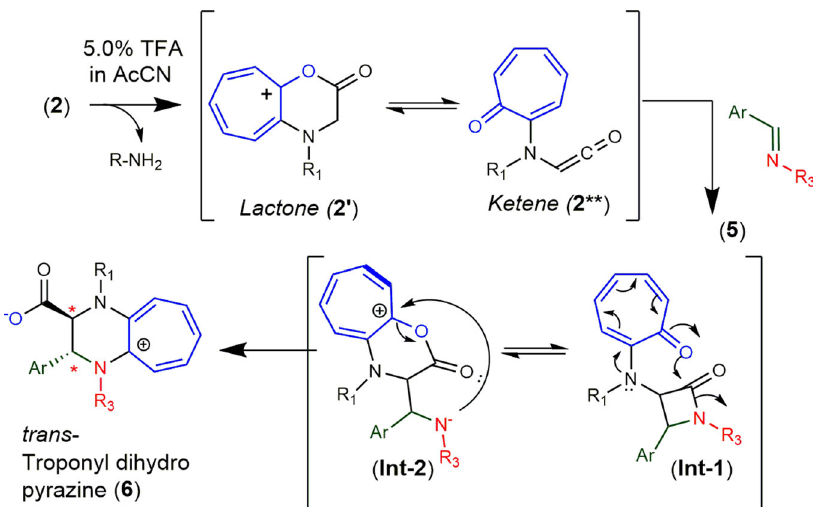
Fig. 3 The plausible reaction mechanism for the formation of cATC derivatives. The formation of cATC derivative by a [2 + 2] cycloaddition between ketene and imine followed by unique (Fig. S2 and Table S3) and Supplementary Data 3. The single crystal